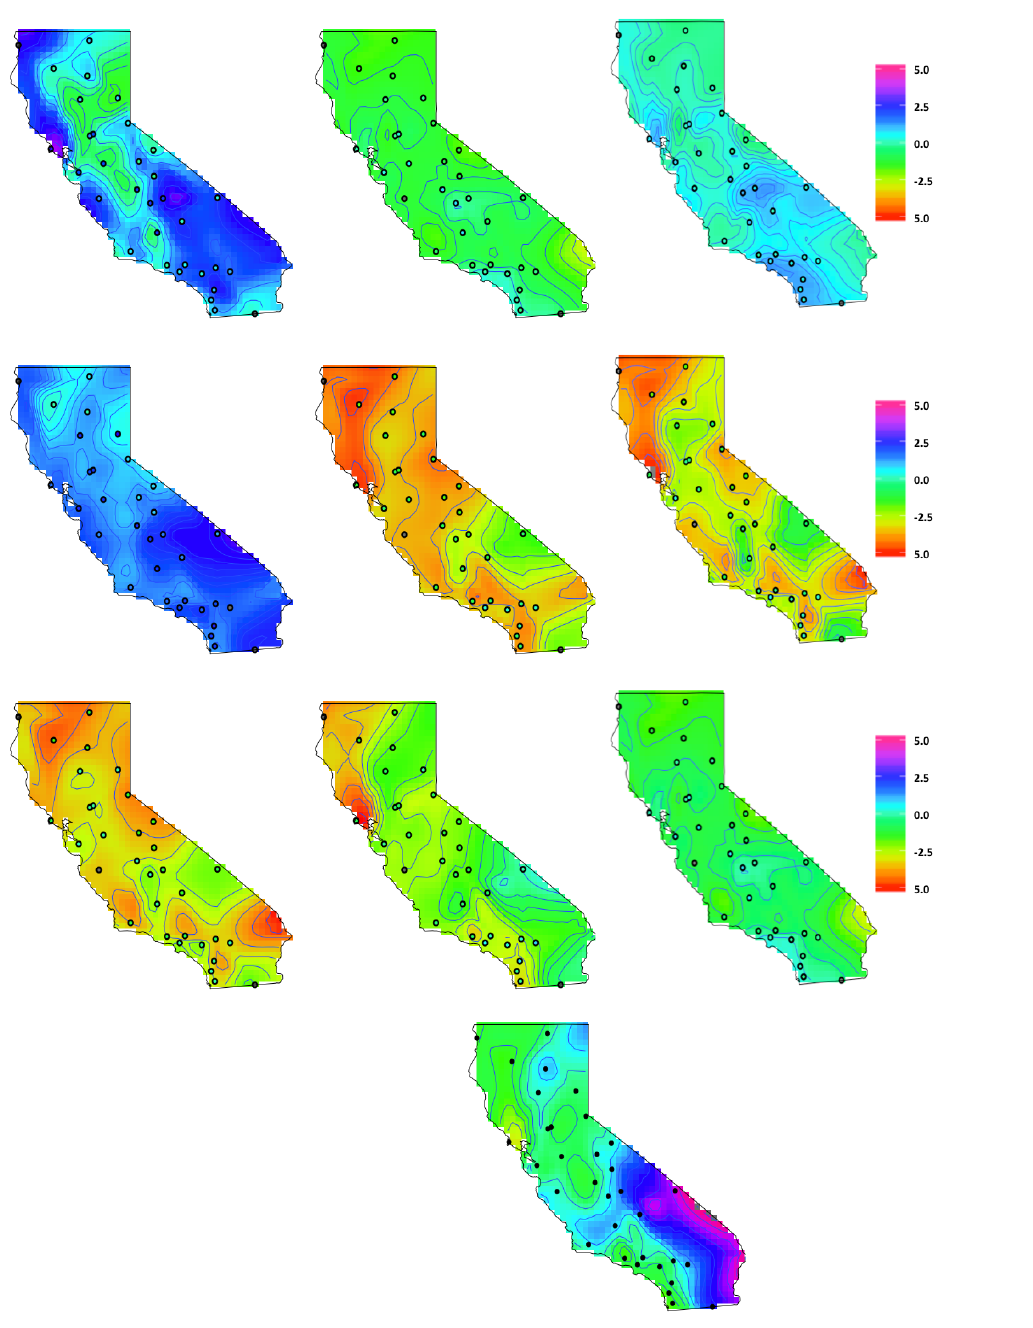
Figure 4. The daily mean standardized latent factors, ( δ − µ δ ) / σ δ , of δ ( s ) are shown in the bottom row. The standardized pollutants, Y , are ( 1st row ) Ammonium, Nitrate, Sulfate, ( 2nd row ) Total Carbon Mass, Calcium, Iron, ( 3rd row ) Potassium, Silicon, Sulfur and ( 4th row ) the Latent Factors. The dots represent the STN and IMPROVE monitoring sites with actual data values shaded in the